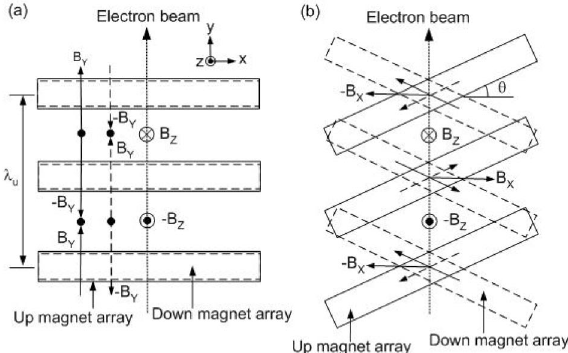
FIG. 1. Schematic top view of the magnetic-pole arrays that are (a) unrotated and (b) rotated in the horizontal plane to produce the pure vertical and the elliptical fields in the planar superconducting undulator. Dashed and solid lines represent the down and up magnet arrays,